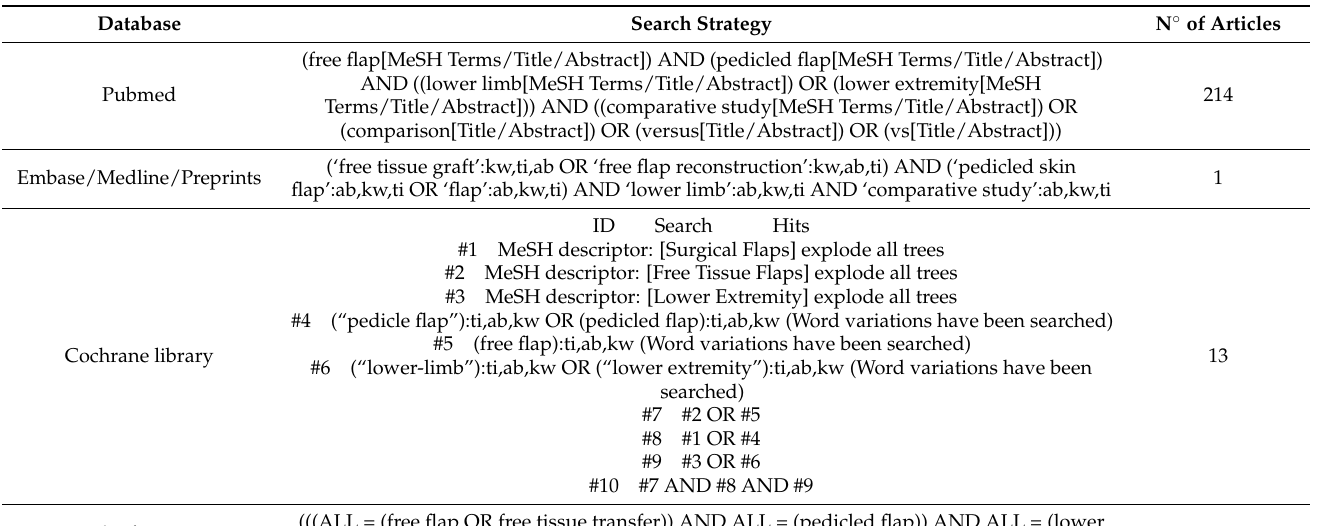
Table 1. Search strategy.